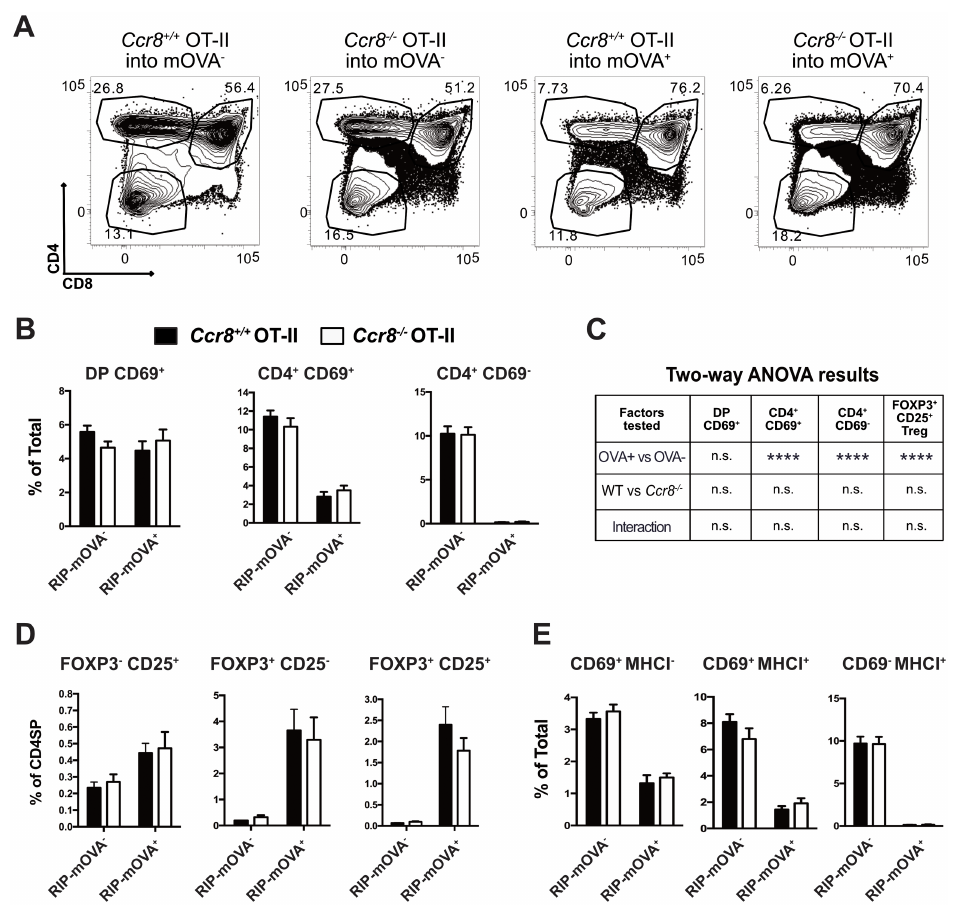
Fig 4. CCR8 is dispensable for negative selection, Treg induction, and differentiation of monoclonal CD4SP thymocytes responding to a model TRA. (A) Representative CD4 versus CD8 flow cytometric profiles of thymocytes analyzed after transplantation of Ccr8 +/+ OT-II or Ccr8 -/- OT-II bone marrow progenitors into RIP-mOVA + or RIP- mOVA - recipients, as indicated. Thymocyte chimerism was analyzed 6 weeks after transplantation. (B-E) Analysis of OT-II chimeras shown in (A). (B) The percentages of Ccr8 +/+ and Ccr8 -/- OT-II thymocyte subsets were quantified based on flow cytometric analysis. (C) Two-way ANOVA was used to determine whether the frequency of the indicated thymocyte subsets was significantly impacted by the CCR8 genotype, the presence of OVA, or the interaction of these two factors in the OT-II bone marrow chimeras. (D) Quantification of the percent of each Treg or Treg precursor subset within CD3 + CD4SP compartment, as assessed by flow cytometry. (E) The frequencies of OT-II CD4SP maturation subsets defined by CD69 and MHCI expression were determined by flow cytometry. All graphs depict means + SEM compiled from two independent experiments with a total of n = 6 OT-II Ccr8 +/+ ! RIP mOVA - ; n = 5 OT-II Ccr8 +/+ ! RIP mOVA + ; n = 6 OT-II Ccr8 -/- ! RIP mOVA - ; n = 6 OT-II Ccr8 -/- ! RIP mOVA + bone marrow chimera